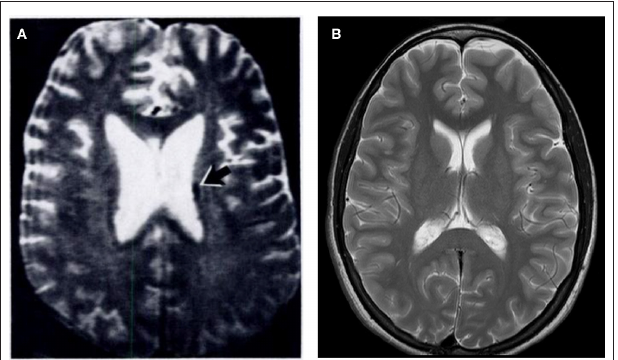
FIGURE 1 | T 2 -weighted MR brain images acquired at 1.5T in (A) 1986. Image reused, with permission, from Zimmerman et al. [8] and (B) 2009 (authors’ database).